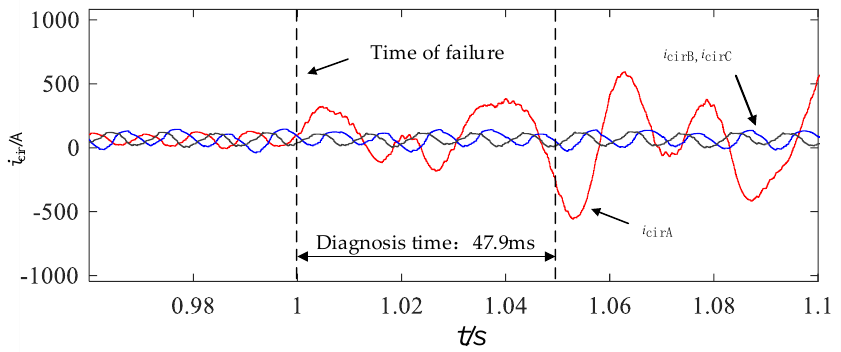
Figure 11. Simulation waveform of i cirA under phase A upper bridge arm inductor short-circuit fault. The simulation results of a short-circuit fault in the upper bridge SM 1 S 1 of phase A in a three-phase MMC system are shown in Figure 12. The S1 short-circuit fault was set to occur at 1 s. After the fault occurred, the fault classification was completed at 1.0479 s, taking 47.9 ms.